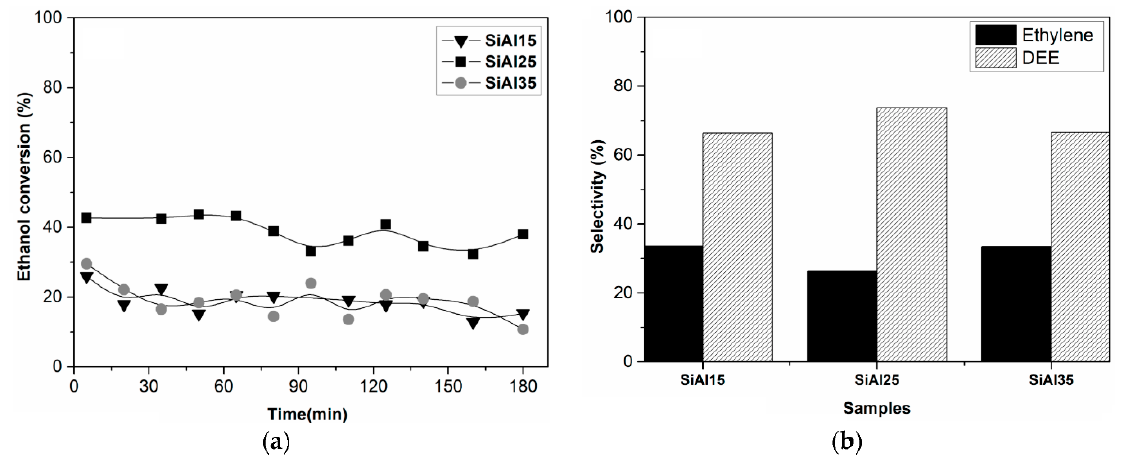
Figure 7. ( a ) Ethanol conversion of the calcined [Al] HPM-1 samples as a function of time at 250 °C and ( b ) product selectivity (Reprinted from [34]).